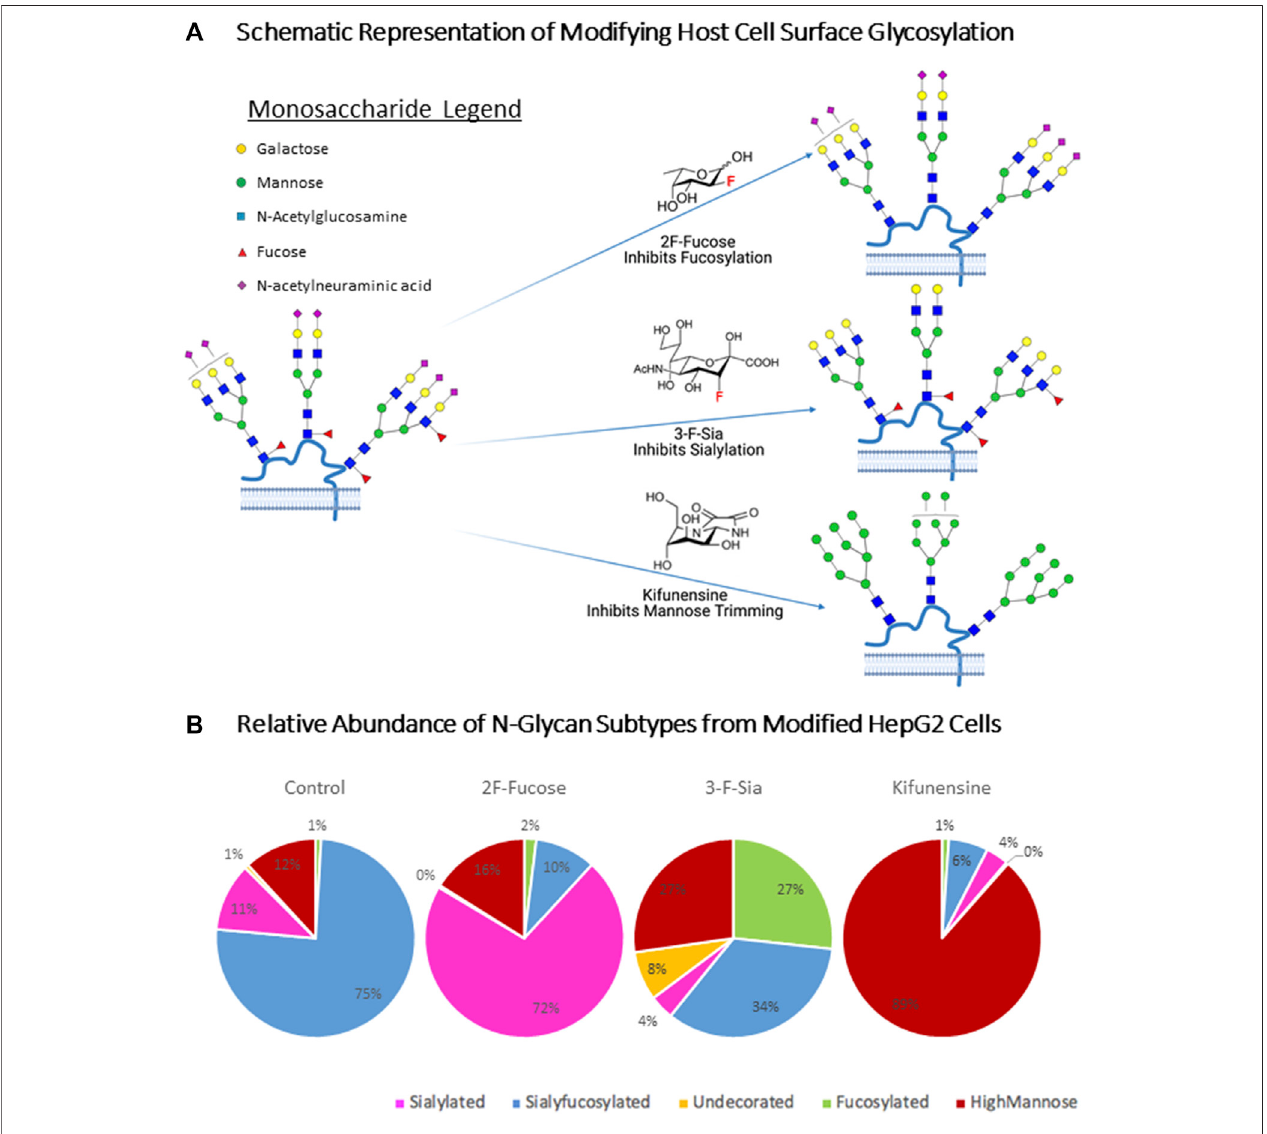
FIGURE 4 | Host Cell Surface Glycome Modi fi cation. 2F-Fucose (Fucosyltransferase Inhibitor); 3-F-Sia (Sialyltransferase Inhibitor). (A) Metabolic engineering stargey for altering host cell glycosulation. Symbol nomenclature is used for representing glycan structures (https://www.ncbi.nlm.nih.gov/glycans/snfg.html). (B) N-Glycome Pro fi les of unmodi fi ed and modi fi ed HepG2 cells from LC-MS analysis. Compound list and details are shown in Supplementary Table S3 . Pie charts were color coded to assign glycan subtype. Numbers inside pie charts denote the relative abundance of each identi fi ed glycan